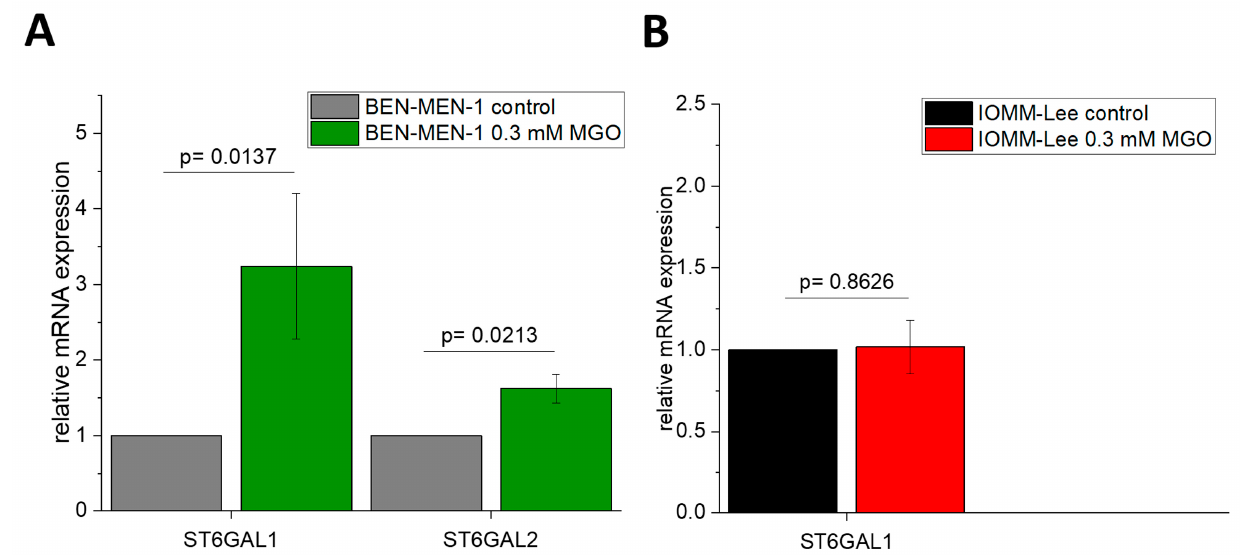
Figure 4. Relative mRNA expression of ST6GAL1–2 in BEN-MEN-1 ( A ) and IOMM- Lee ( B ). ( A ): Normalized control (grey) and mRNA expression after 24 h treatment with 0.3 mM MGO (green). ( B ): Normalized control (black) and the mRNA expression after 24 h treatment with 0.3 mM MGO (red). Statistical analysis was performed using t -test and error bars represent SD ( n = 4; ST6GAL1 : p = 0.0274 ( A ), p = 0.863 ( B ); ST6GAL2 : p = 0.0213 ( A )).